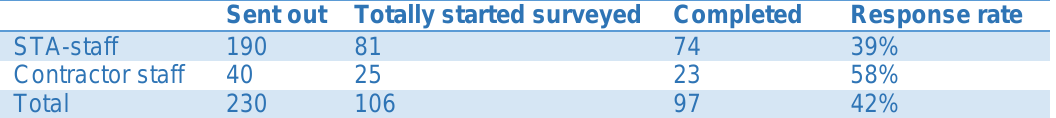
Table 1: The number of survey participants and the response rate Sent out Totally started surveyed Completed Response rate STA-staff 190 81 74 39% Contractor staff 40 25 23 58% Total 230 106 97